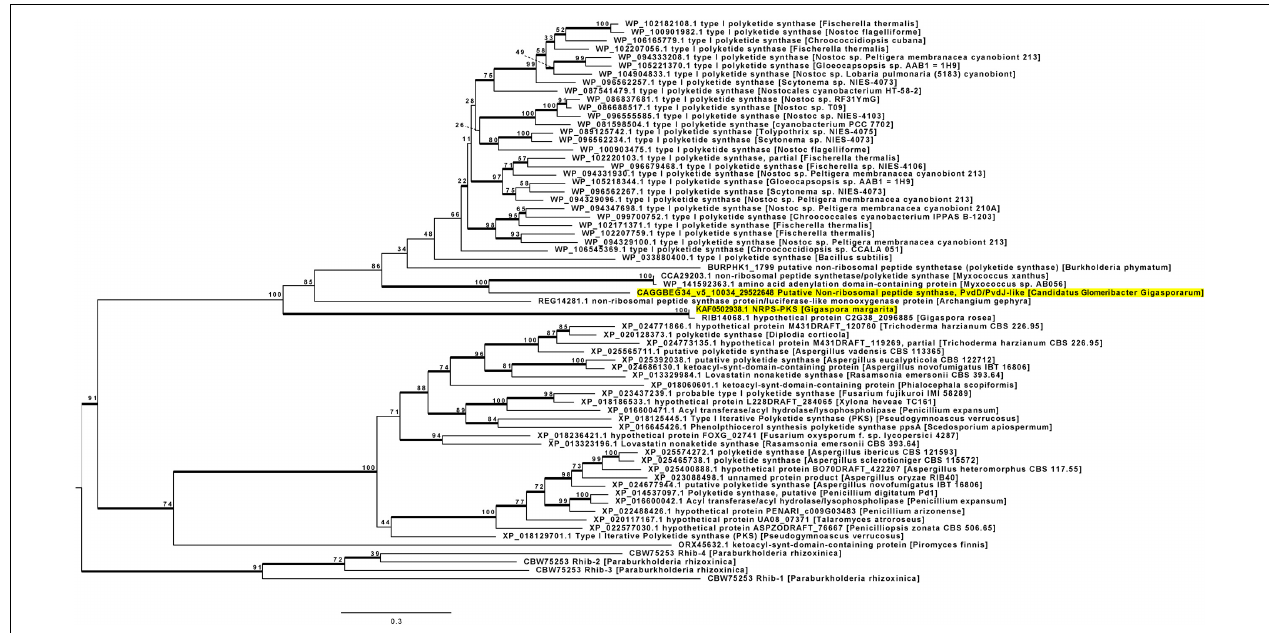
FIGURE 3 | ML tree based on the KS domain of KAF0502938.1, a hybrid NRPS-PKS of G. margarita . The sequence of G. margarita , as well as that of its endobacterium, Ca Gg, are highlighted. The sequences of G. margarita and G. rosea are gathered into a bacterial clade which is well separated from the Dikarya group. The sequence of the Ca Gg endobacterium clusters into a sub-clade which is well separated from the Gigaspora sequences, but which contains sequences from Myxococcus . Despite its homology with the Gigaspora sequences, the PKS from the basal fungus P. finnis seems to have a fungal signature. Bootstrap support values are shown on the tree nodes. Thick lines indicate Bayesian posterior probability ≥